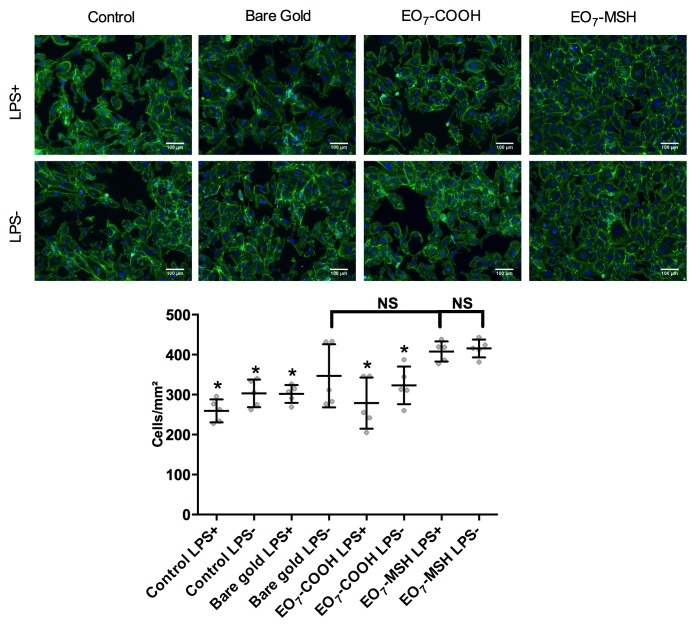
HUVEC adhesion.(A) Epifluorescence images of Endothelial cells that were re-plated onto bare gold, EO7-COOH, EO7-MSH surfaces and culture dish (control) in culture medium containing 1μg/mL lipopolysaccharide (LPS+) or normal culture medium (LPS-). Cell were stained for actin (green) and nuclei (blue). (B) The fluorescence images were analyzed to determine the average number of adherent cells per mm2 after cells were adhered for 24h. Error bars represent standard deviations. A Bonferroni test relative to EO7-MSH LPS+ vs. other surfaces was performed. Differences were considered significant for p<0.01 and marked with an asterisk. The number of replicates is n = 5.